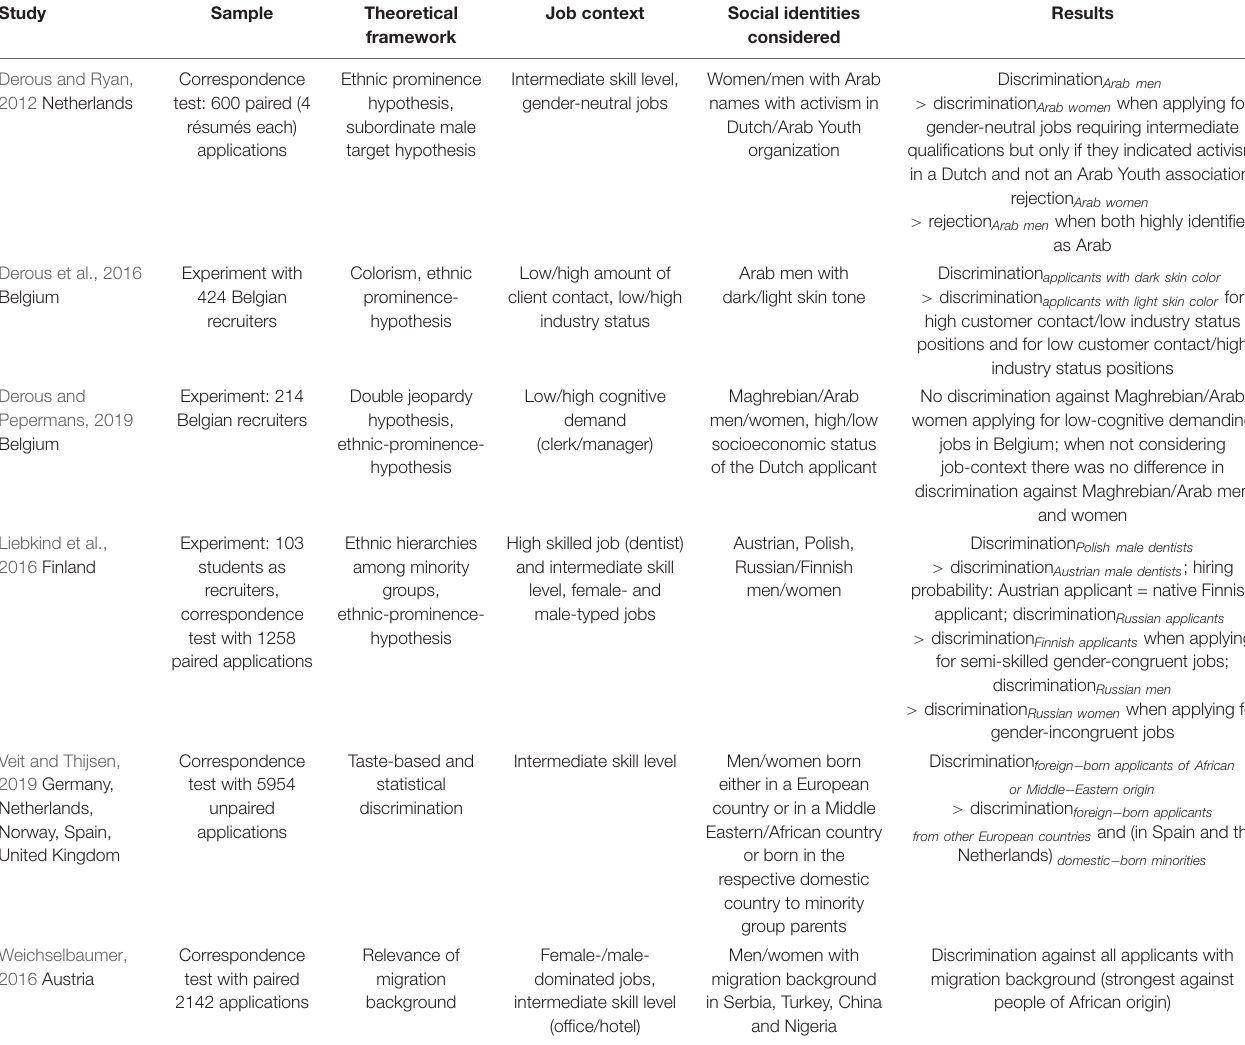
TABLE 4 | Overview of European social psychological studies on labor market discrimination based on the ethnic prominence